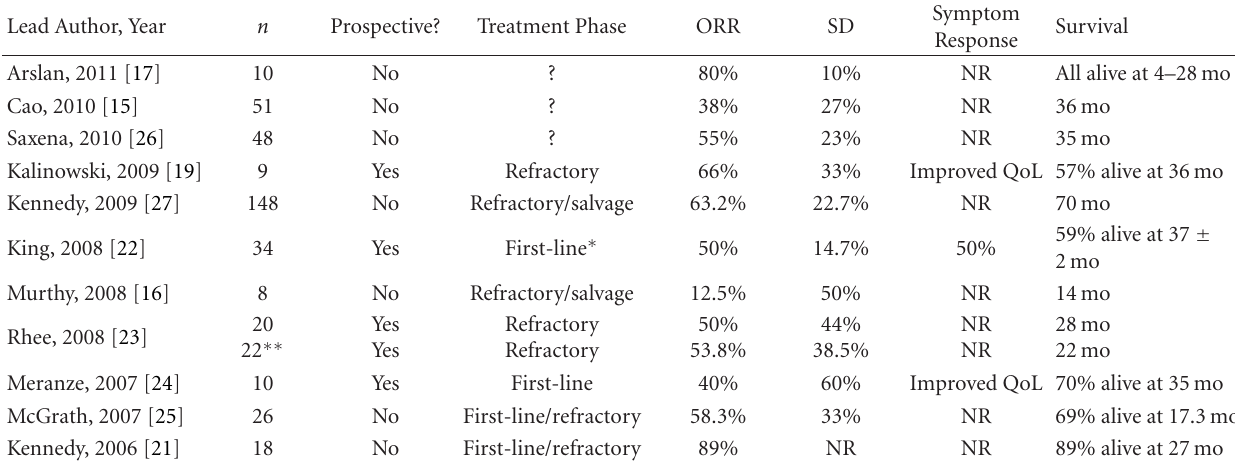
Table 1: Study outcomes of TARE for NET liver